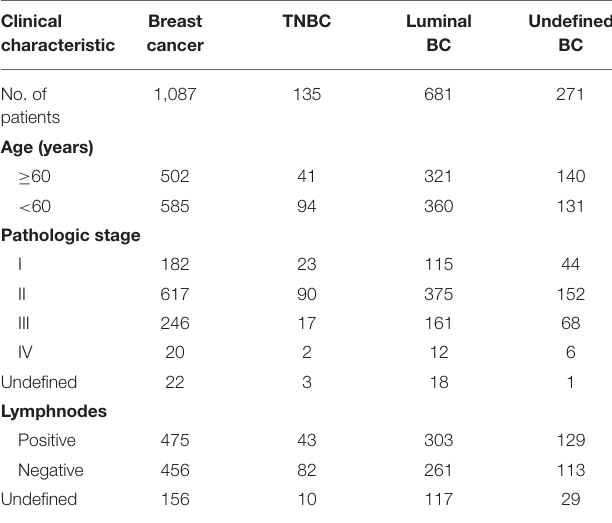
TABLE 1 | Clinical characteristics of breast cancer (BC)